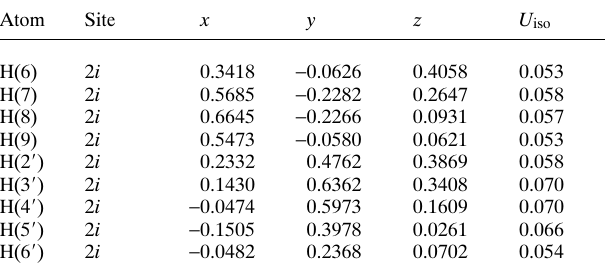
Table 2. Atomic coordinates and displacement parameters (in Å 2 ) .